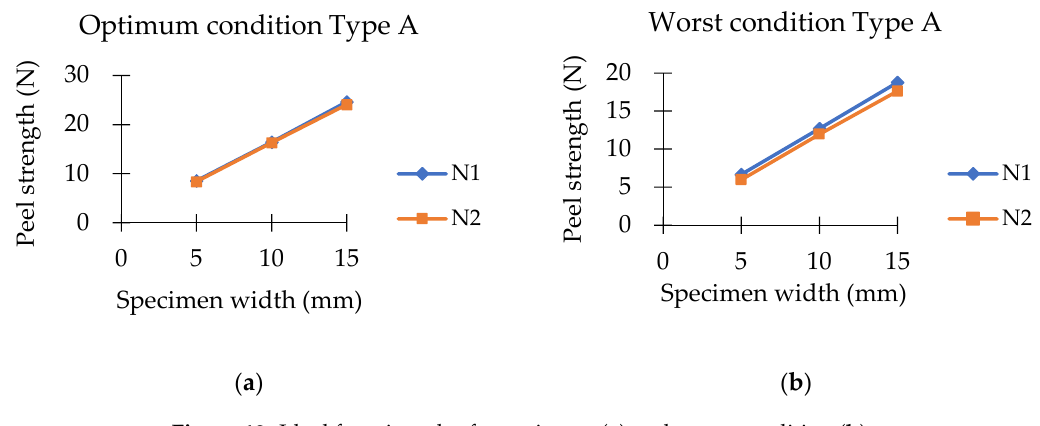
Figure 10. Ideal function plot for optimum ( a ) and worst condition ( b ). Table 3. Optimum and worst condition with confirmation run.